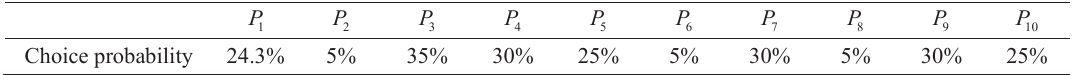
Table 11. Customer selection probabilities of 20 alternative product variants